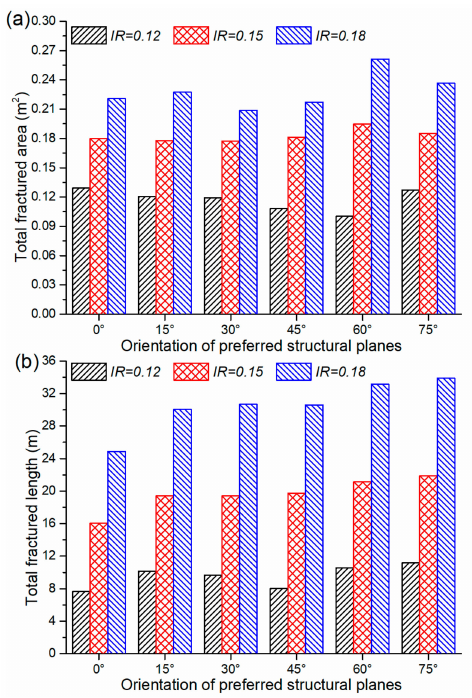
Figure 17. Total fractured area ( a ) and total length of fractures ( b ) for di ff erent injection rates. The boundary stress was the same as with the base